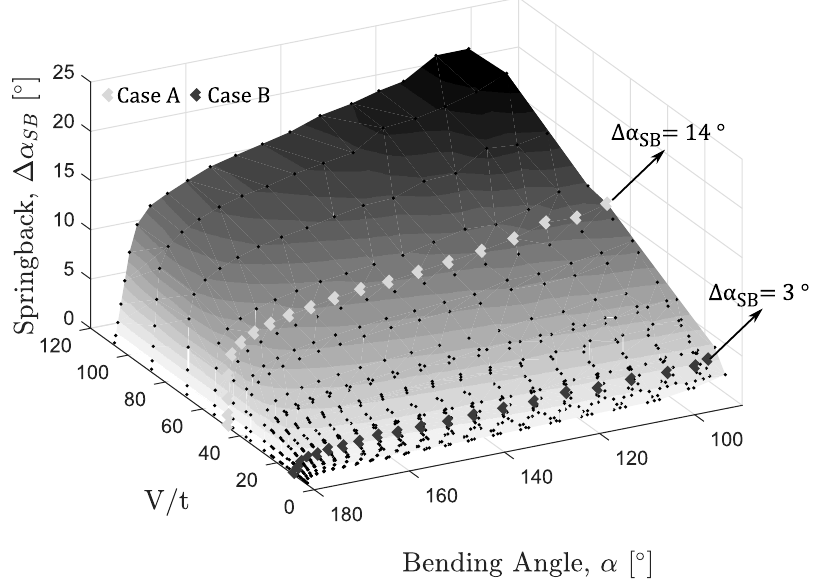
Figure 6. Springback angle values ( ∆ α SB ) for different bending conditions ( V / t ratios) and consider- ing different required bending angles ( α